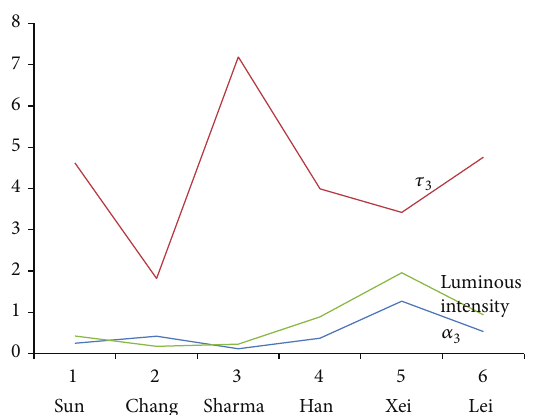
Figure 2: Relationships between the luminous intensity (measured at 2 min), 𝛼 3 , and 𝜏 3 for the data listed in Table 2.